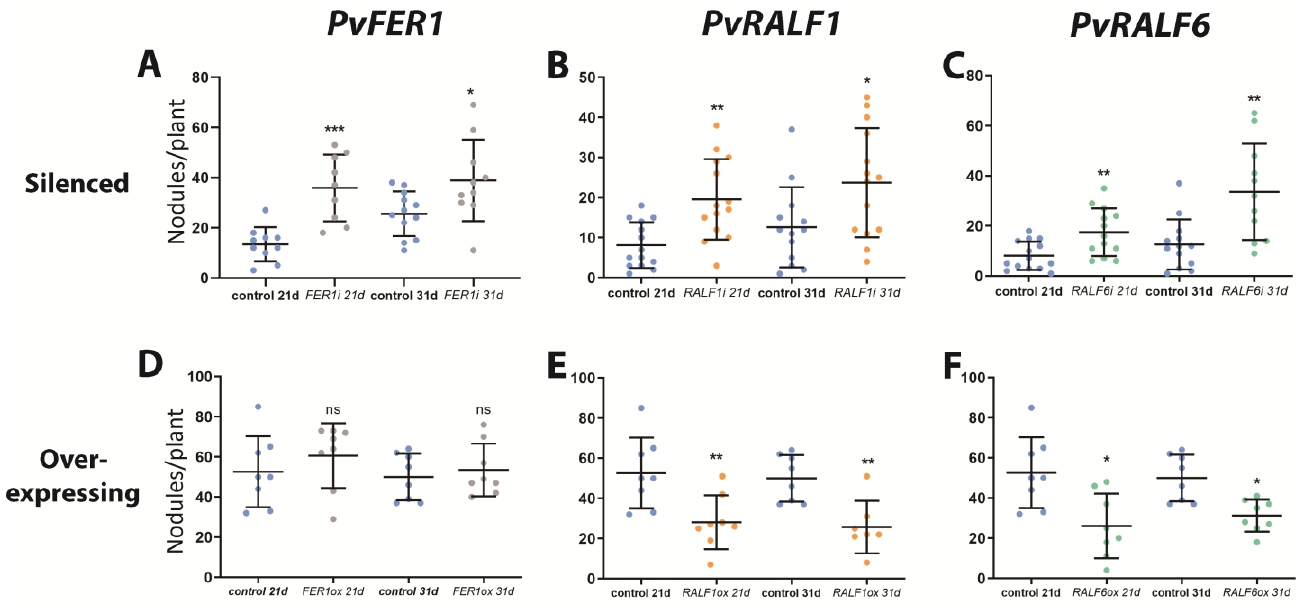
Figure 6. PvFER1 , PvRALF1 , and PvRALF6 have a negative effect in regulating the nodule number in 5 mM nitrate. ( A – F ) Effect of silencing and overexpression of PvFER1 (gray dots, A , D ), PvRALF1 (orange dots, B , E ) and PvRALF6 (green dots, C , F ) on the number of nodules at 21 and 31 dpi. Blue dots are the controls in each case (SAC for silenced and GUS for overexpressing roots). The lines represent the mean ± SD. Data from three independent experiments are represented as dots ( n ≥ 9). A non-parametric Mann–Whitney test was used to assess significant differences. * p < 0.05, ** p < 0.01, *** p < 0.001; ns = not significant.